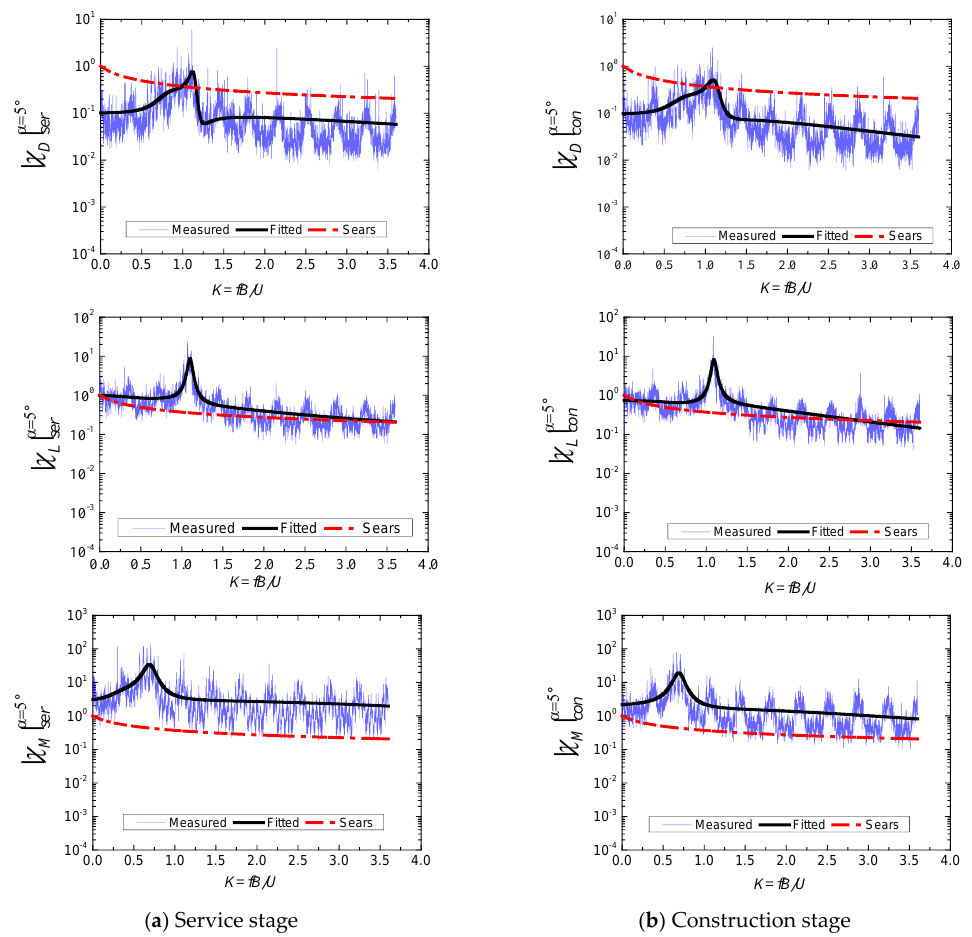
Figure 10. AAFs identified for the DDTG under the service and construction stages at α = 5°.